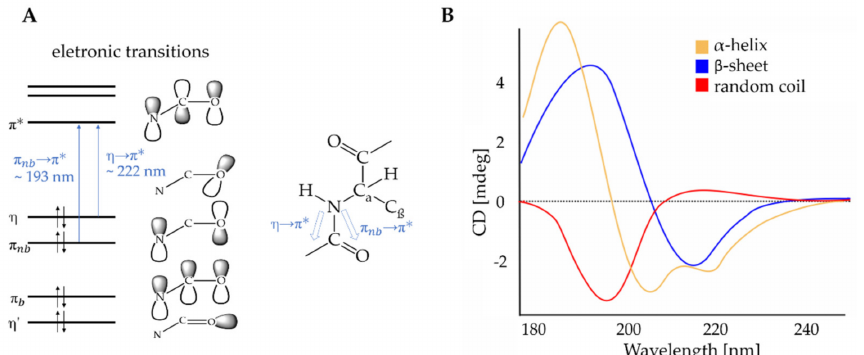
Figure 10. ( A ) Energy level diagram with electronic transitions of a peptide bond in the far UV region. Bonding, non-bonding, and antibonding p-orbitals ( π b , π nb and π ∗ ) and two free electron pairs at the oxygen ( η and η (cid:48) ) are shown [75,76]. ( B ) Characteristic CD spectra in the far UV region of “pure” α -helix, β -sheet, and disordered structures, redrawn from